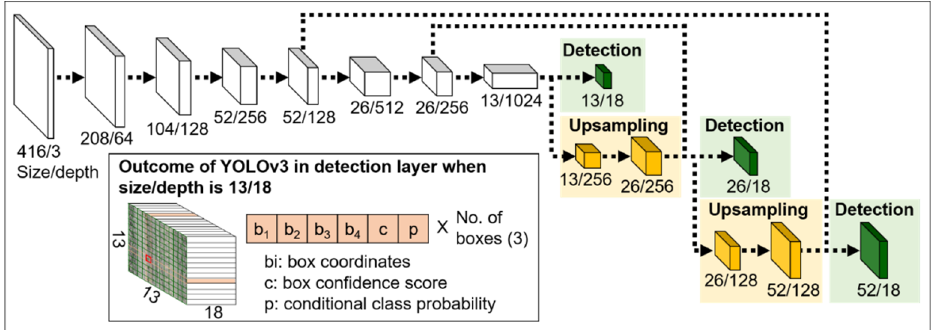
Figure 4. Network architecture of YOLOv3 and its outcome.